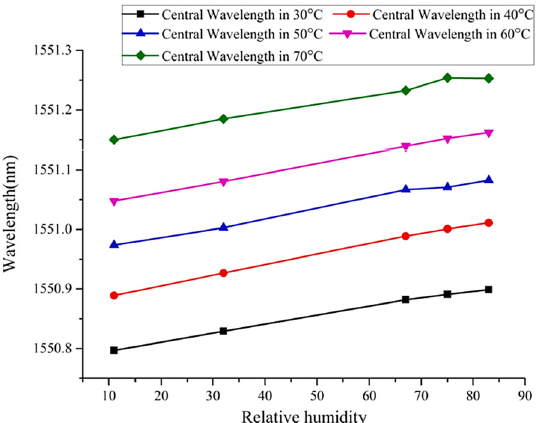
Figure 36. Point sensor. Bragg wavelength as a function of RH at different temperature settings. Reprinted with permission from ref. [193]. Copyright 2021 Elsevier .